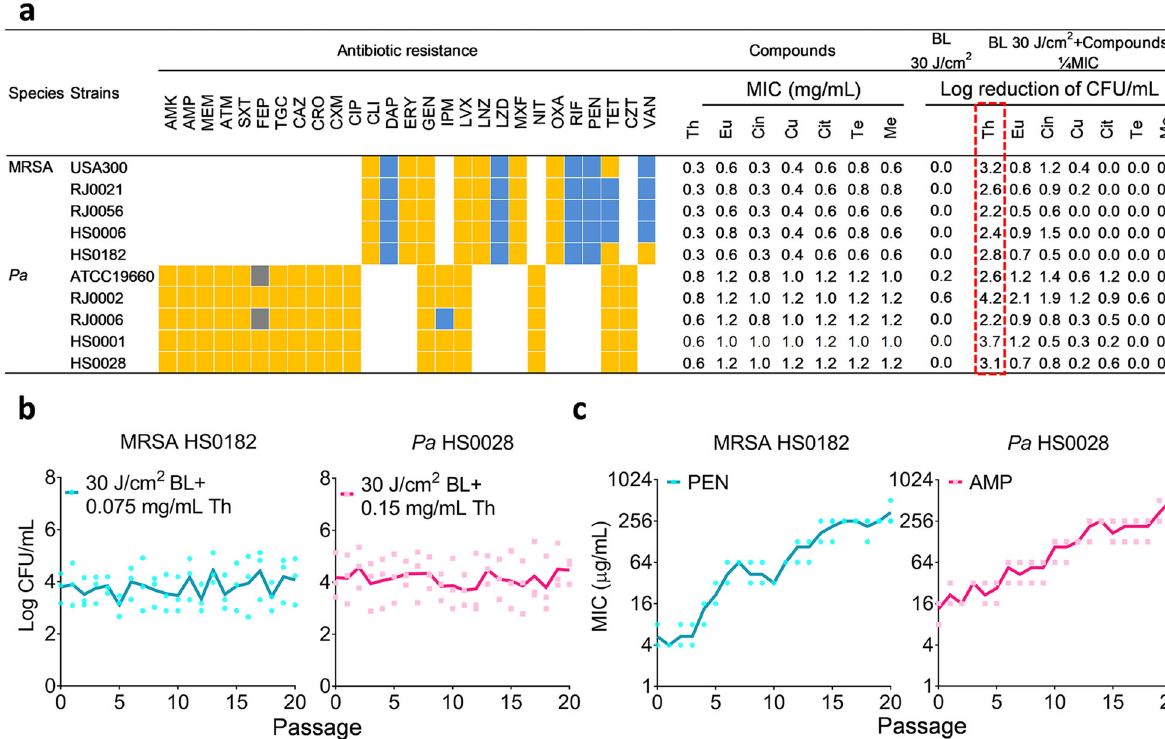
Fig. 1 Screening bactericidal activity of BL combined with essential oil compounds. a Bacteria of 5 MRSA and 5 Pa strains were tested for their susceptibility to various antibiotics: susceptible (blue boxes), intermediate (gray boxes), or resistant (yellow boxes) and MIC values to Th (thymol), Eu (eugenol), Cin (cinnamaldehyde), Cu (cuminaldehyde), Cit (citral-a), Te (terpinen-4-ol), and Me (menthol). Bactericidal ef fi cacies of 30 J/cm 2 BL in the absence and presence of an indicated compound at 1/4 MICs were obtained against the 10 MDR strains. b and c Resistance development of MRSA HS0182 and Pa HS0028 to the sub-lethal doses of BL plus thymol ( b ), penicillin (PEN) alone ( c , left), or ampicillin (AMP) alone ( c , right), respectively. Each value represents the mean of triplicate assays. Antibiotics in a : AMK, amikacin; MEM, meropenem; ATM, aztreonam; SXT, trimethoprim-sulfamethoxazole; FEP, cefepime; TGC, tigecycline; CAZ, ceftazidime; CRO, ceftriaxone; CXM, cefuroxime; CIP, cipro fl oxacin; CLI, clindamycin; DAP, daptomycin;